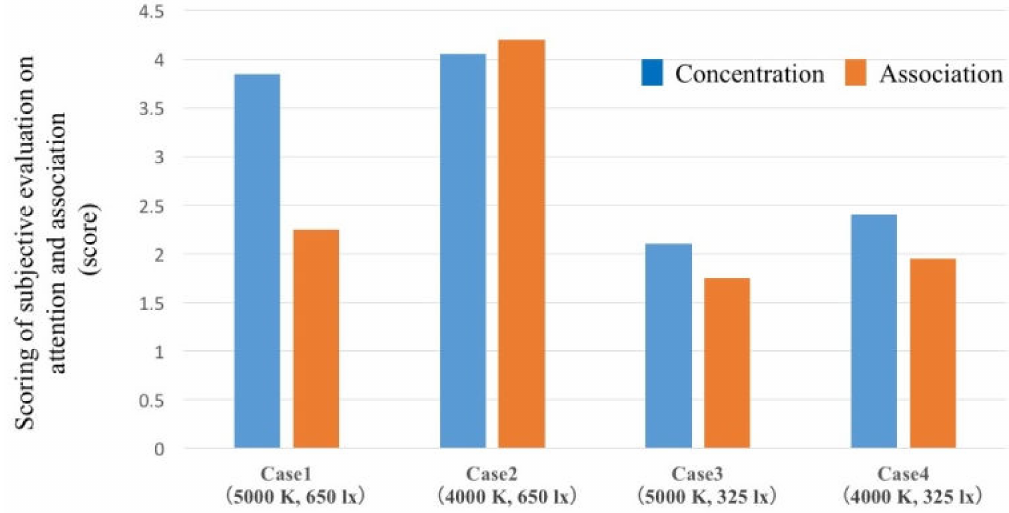
Figure 7. Average scores of evaluation on “concentration” and “association” in di ff erent illumination environments.